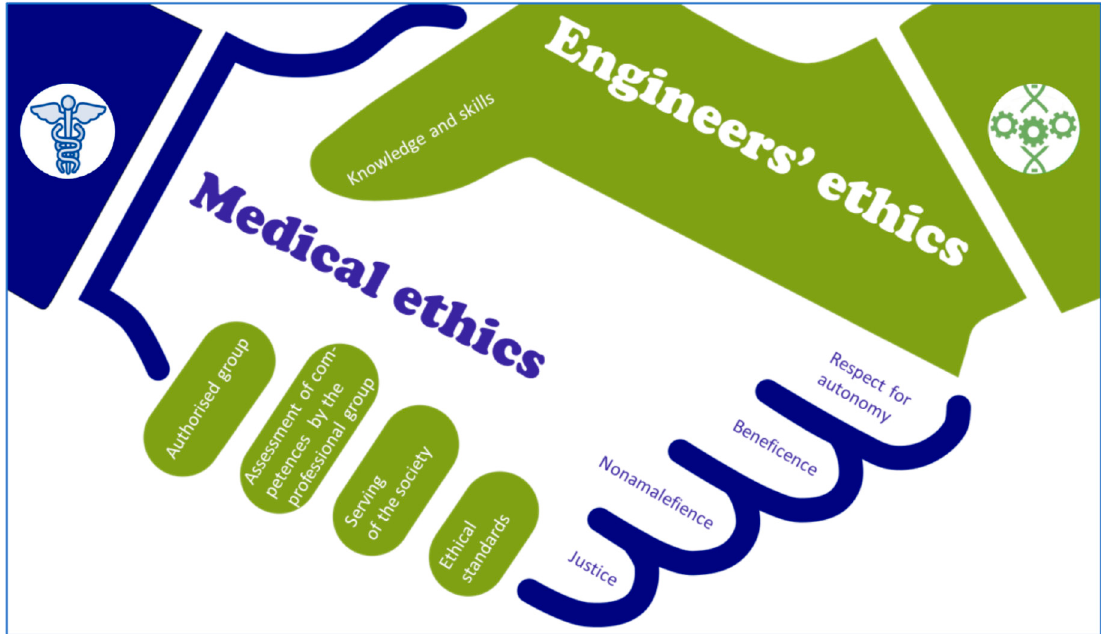
Figure 14. Diagram of the coincidence of ethical principles of the medical and engineering communities necessary for implementing therapeutic tasks requiring cooperation with bioengineers.